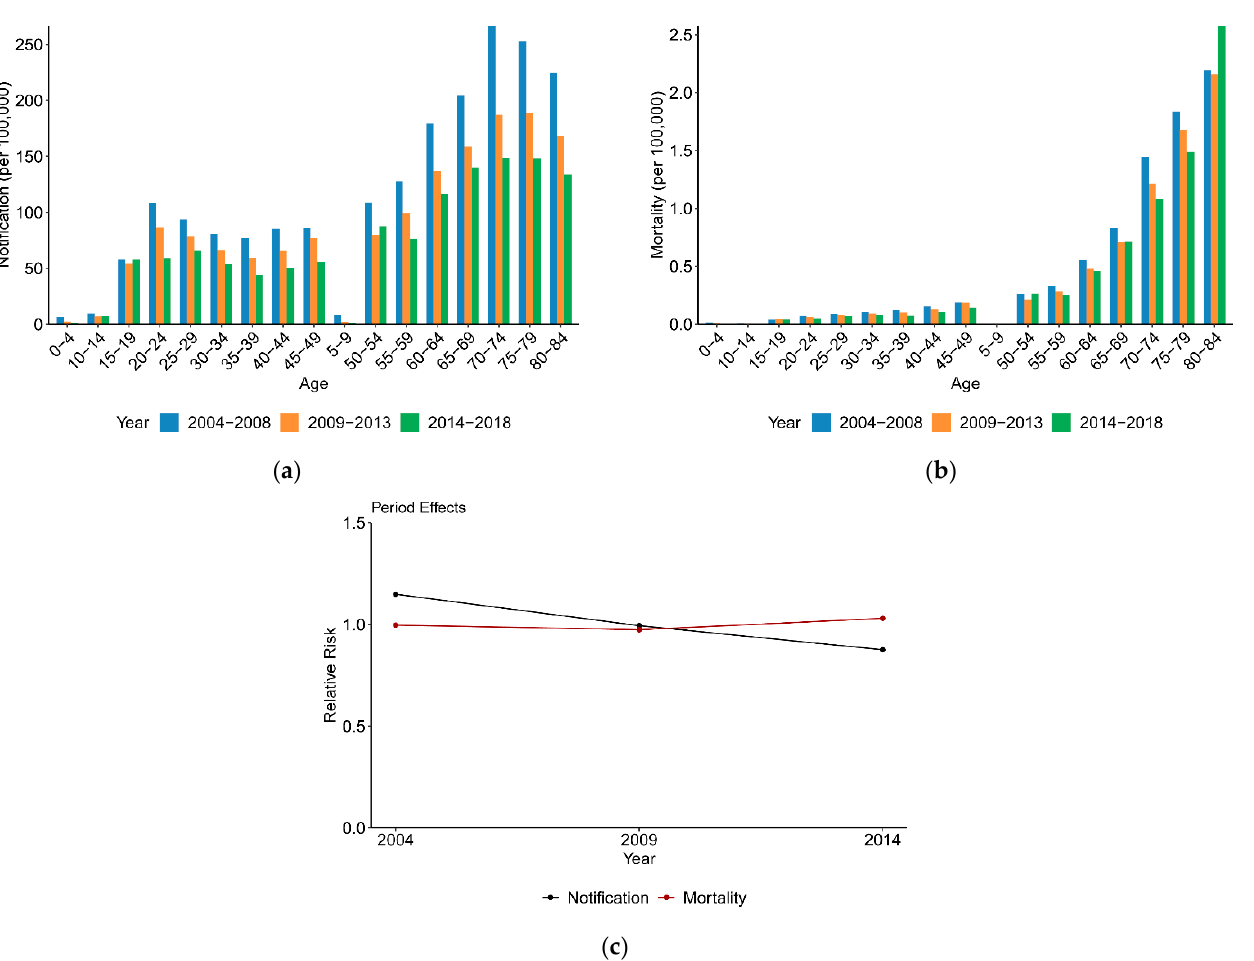
Figure 3. TB notification and mortality variation with period between 2004 and 2018, and the period effects on TB notification and mortality. ( a ) TB notification variation with period. ( b ) TB mortality variation with period. ( c ) Period effects.